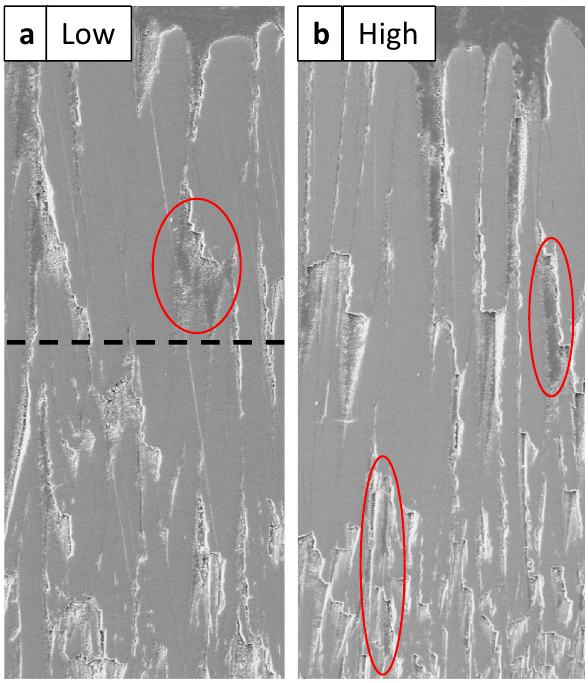
Fig. 7 CMAS infiltration depths of ( a ) Low and ( b ) High deposition rate conditions on interrupted samples. Visible sections of CMAS infiltration are circled in red. Samples were removed from testing at half their expected lifetimes and showed no signs of delamination